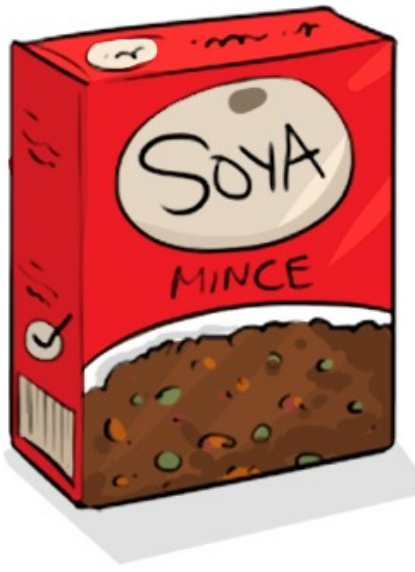
Figure 6. Soya before adaptation.